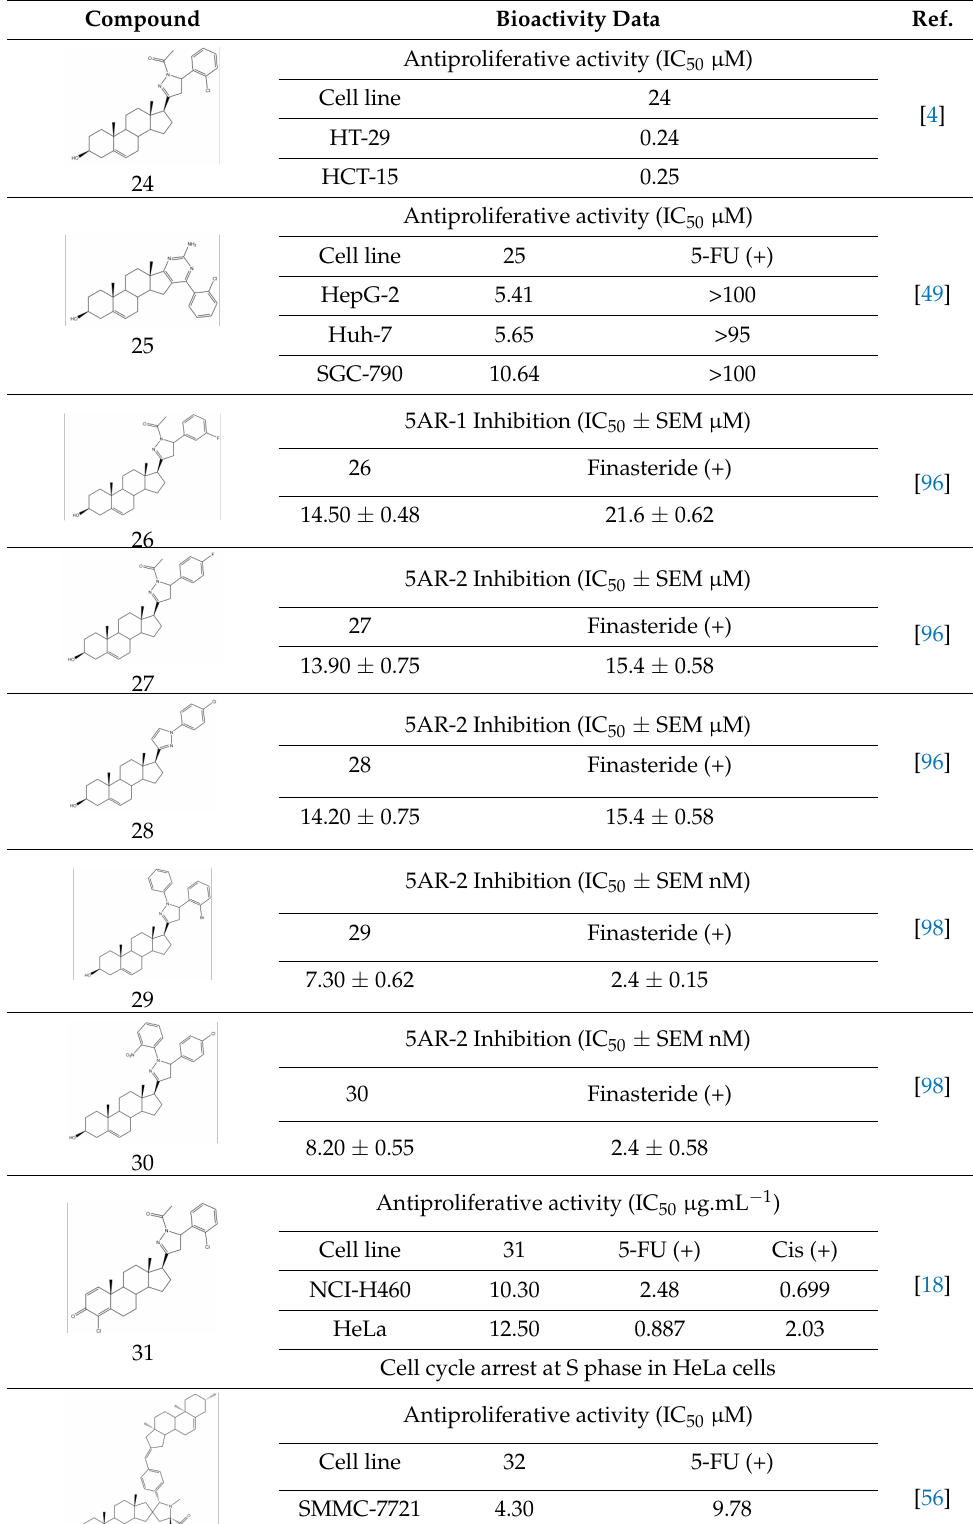
Table 4. The most active heterocyclic steroidal derivatives obtained from arylidenesteroids. Positive controls, when shown, are identified by (+)